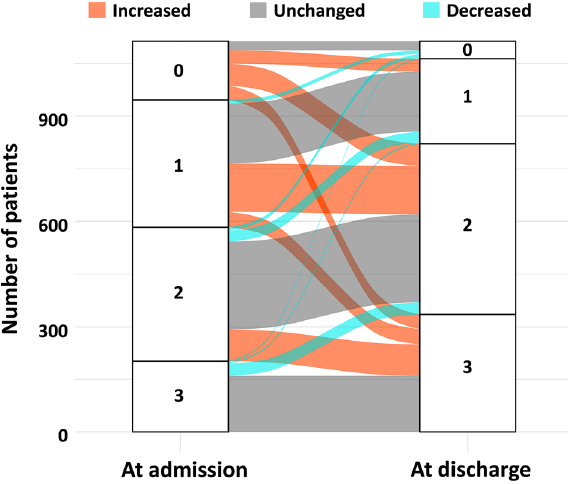
Figure 1. Change in the number of prescribed FMHF classes during hospitalization Alluvial plot showing the number of patients who remained in the same number of FMHF categories or transitioned to a different category from admission to discharge. FMHF foundational medications for heart failure.